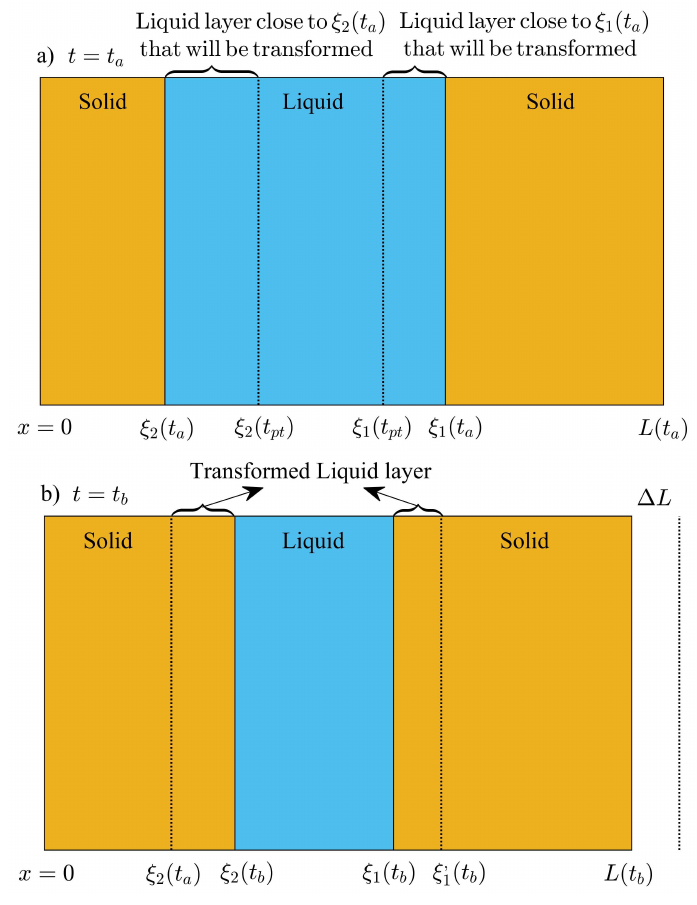
Figure 6. Schematic illustration of liquid layers ξ 2 ( t pt ) − ξ 2 ( t a ) and ξ 1 ( t a ) − ξ 1 ( t pt ) , before and after the phase transition. ( a ) Saturated liquid layers before the transformation at some time t = t a . The thickness of each liquid layer ξ 2 ( t pt ) − ξ 2 ( t a ) and ξ 1 ( t a ) − ξ 1 ( t pt ) is obtained by applying mass conservation. ( b ) Transformed liquid layers after the phase transition at some time t = t b . The thickness of each solid layer ξ 2 ( t b ) − ξ 2 ( t a ) and ξ (cid:48)